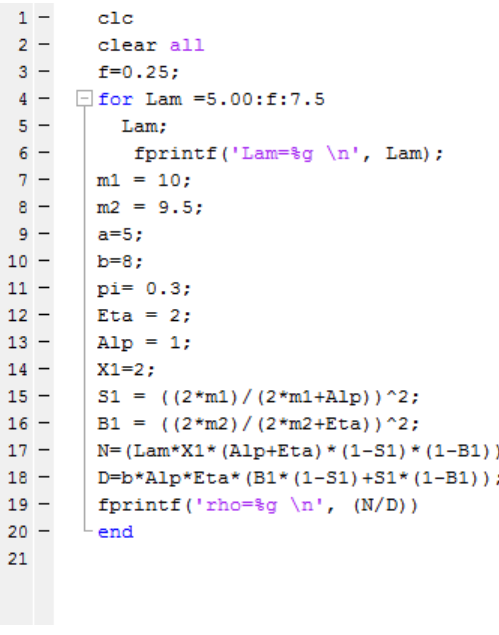
Figure 2. MATLAB code for finding the rho